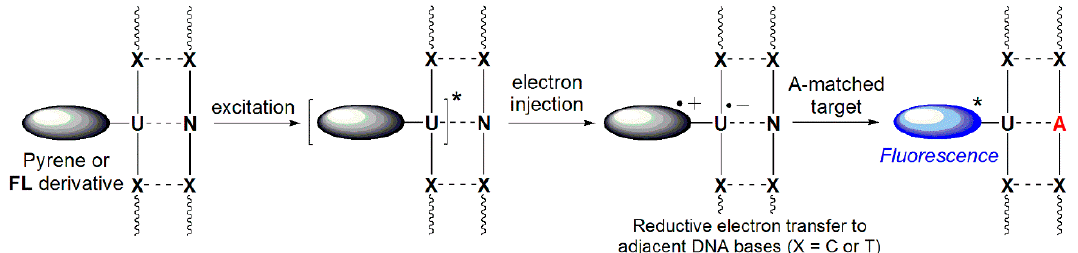
Figure 13. Working mechanism of quencher-free linear beacon systems.